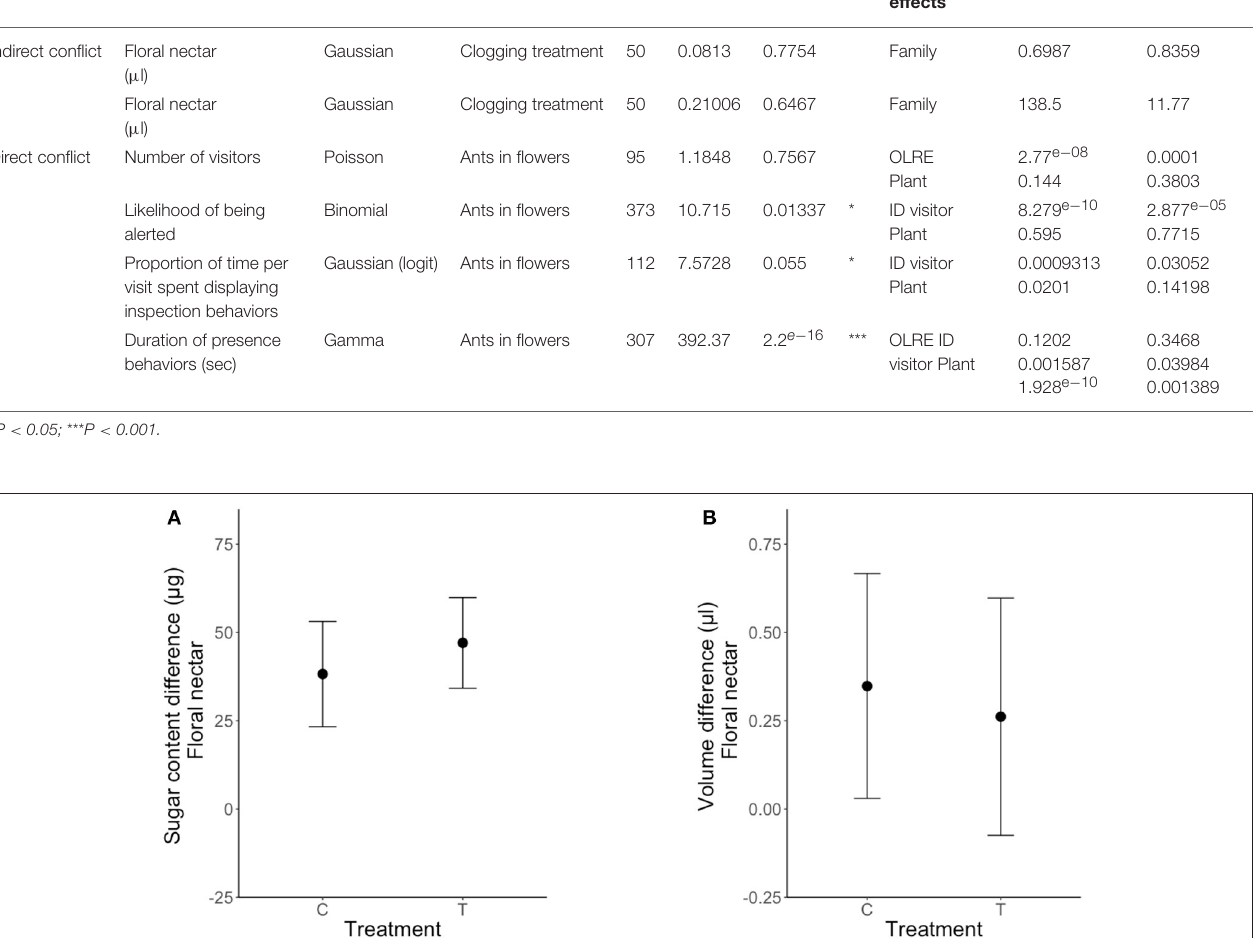
Turnera subulata , and Turnera joelii ), when sampling FN in